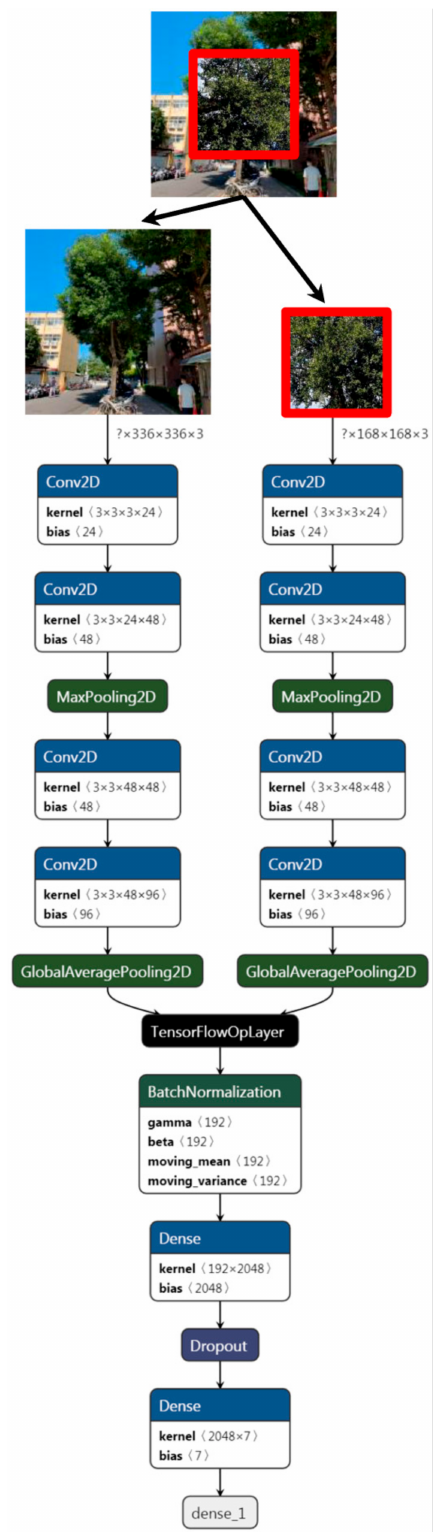
Figure 3. Architecture of the proposed dual path CNN framework. The left path is the backbone CNN architecture, and the right one is the central attention path with the central crop of the input image. Feature maps in the central attention path were concatenated with the corresponding backbone feature before class score